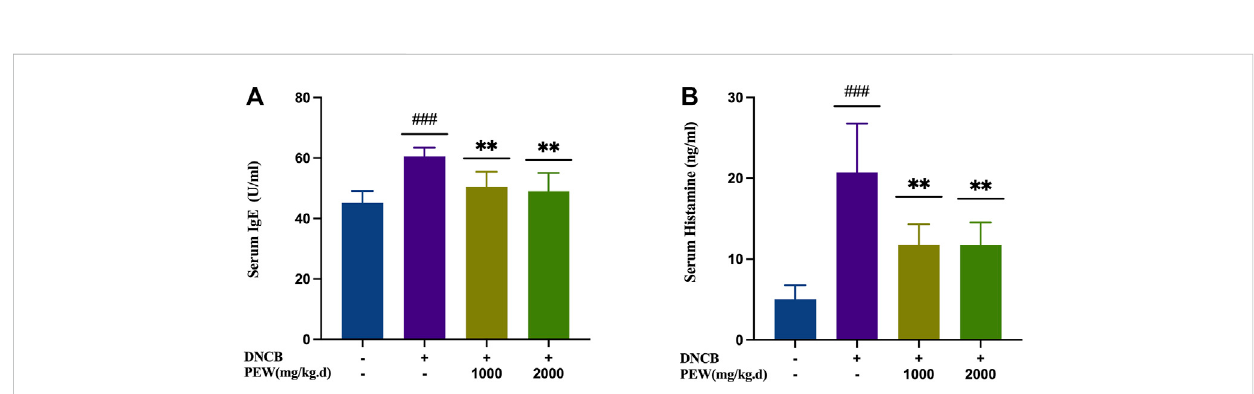
FIGURE 4 Effects of PEW on serum levels of IgE and histamine in DNCB-induced AD mice. (A) Levels of IgE in serum ( n = 6/group). (B) Levels of histamine in serum ( n = 6/group). The data were presented as means ± SD. ### p < 0.001, VS. the normal group; ** p < 0.01, VS. the model control group.